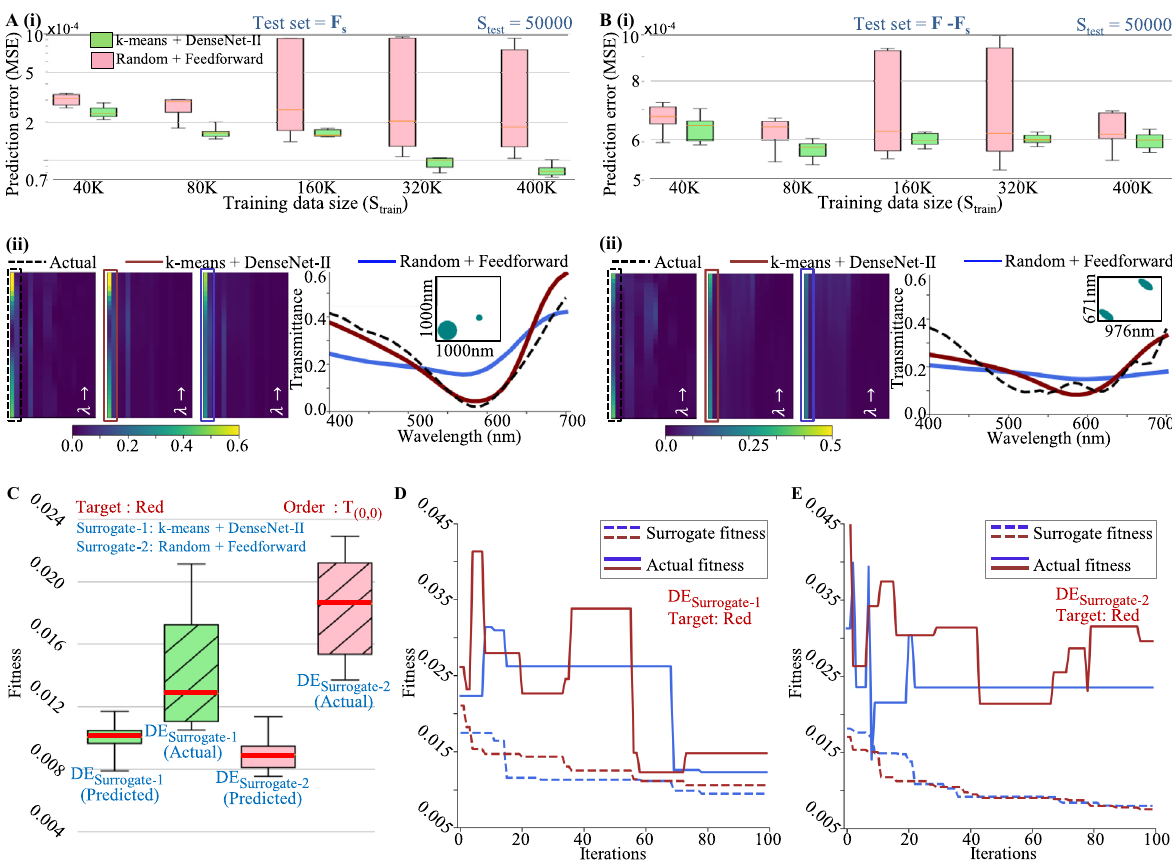
Figure 3: Comparison of the prediction performance on unseen data for two combinations of sampling strategies and network architectures (k-means + DenseNet-I and Random + Feedforward) on two test sets of size 50,000 selected from (A) ( F Statistical comparison of prediction error along with the prediction of one example structure is shown for both cases. (C) Comparison of both trained models’ performances as surrogates in DE optimization. Statistics of multiple runs of DE optimization (100 iterations) for a target design of a polarization-independent color filter (red) are shown. The best surrogate fitness (fitness predicted by surrogates; see Eq. (1)) and the actual fitness values at the end of multiple optimization runs are shown. (D) and (E) Typical progression of fitnesses (with iteration and DE , respectively. For surrogate optimizations, the actual fitnesses (solid lines) and corresponding number) for DE Surrogate-1 Surrogate-2 surrogate fitnesses (dotted lines) are